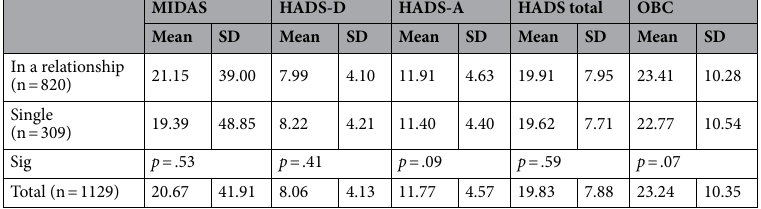
Table 3. Mean scores for the MIDAS, HADS-D, HADS-A, HADS total and OBC in different relationship status groups (SD—standard deviation). SD—standard deviation, MIDAS—Migraine Disability Assessment, HADS—Hospital Anxiety and Depression Scale, OBC—Oral Behaviors Checklist, sig.— p -value for the statistical significance of the analyzed differences (see main text for